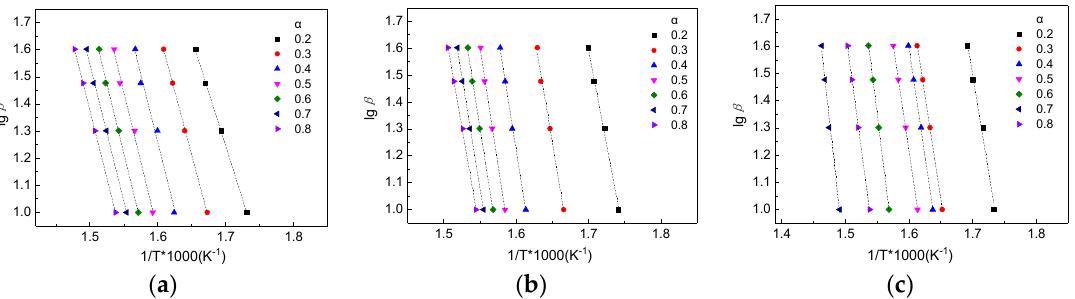
Figure 7. The lg β -1 / T curve of ( a ) untreated wood, ( b ) W-Si and ( c ) W-Si / B residues.